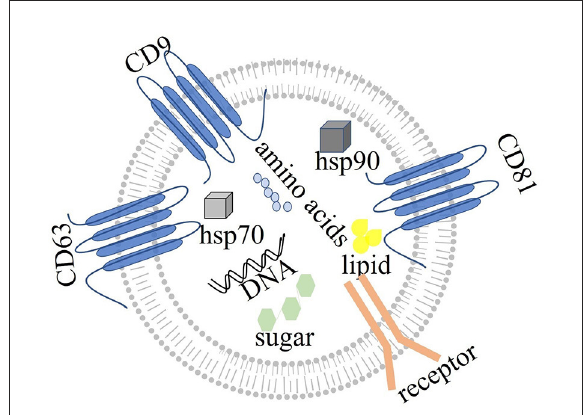
FIGURE2 The structure of exosomes: exosomes, with single membranes, are rich in amino acids, sugar, lipids, and nucleic acids. Exosomes also express specific proteins, such as tetraspanin (CD63, CD81, and CD9), Heat Shock Protein 70 (hsp70), and Heat Shock Protein 90 (hsp90). Exosomes act by binding other cells through membrane